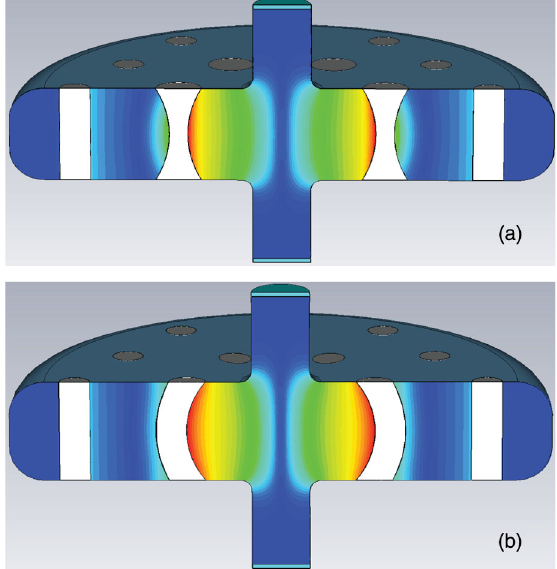
2 (color online). Distribution of the magnetic field in a PBG resonator with: (a) central rods with diameter changing along the rod; (b) bent central rods.